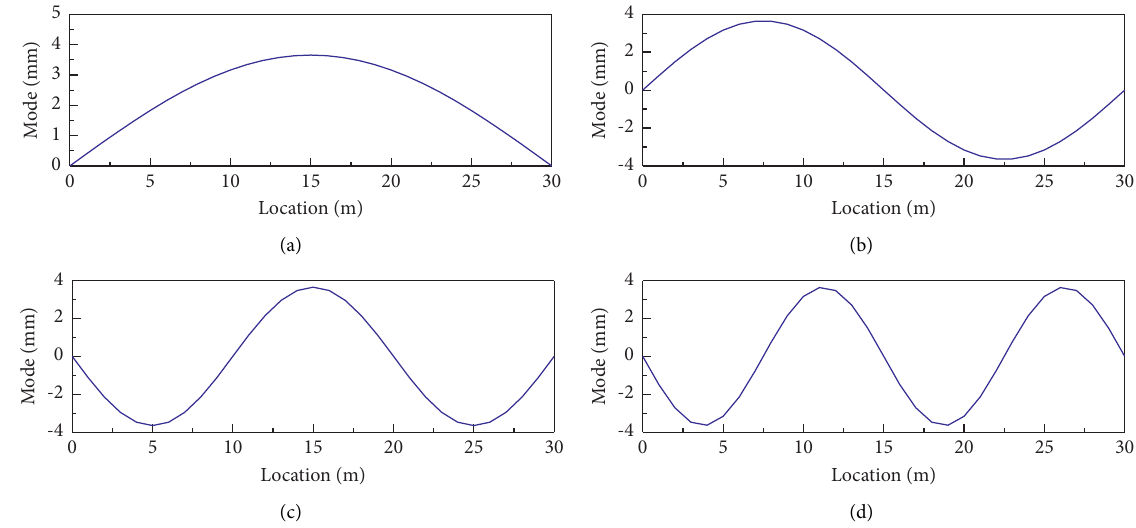
Figure 5: Mode shape of bridge: (a) mode shape 1; (b) mode shape 2; (c) mode shape 3; (d) mode shape Table 4: Parameters of the vehicle [16]. Symbol Unit